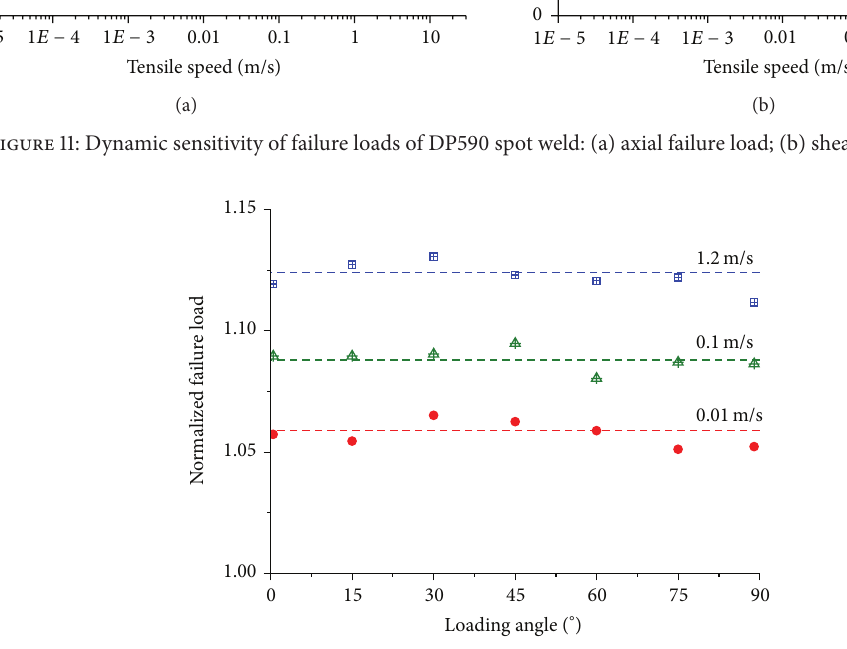
Figure 12: Normalized failure loads of a DP590 spot weld at various loading